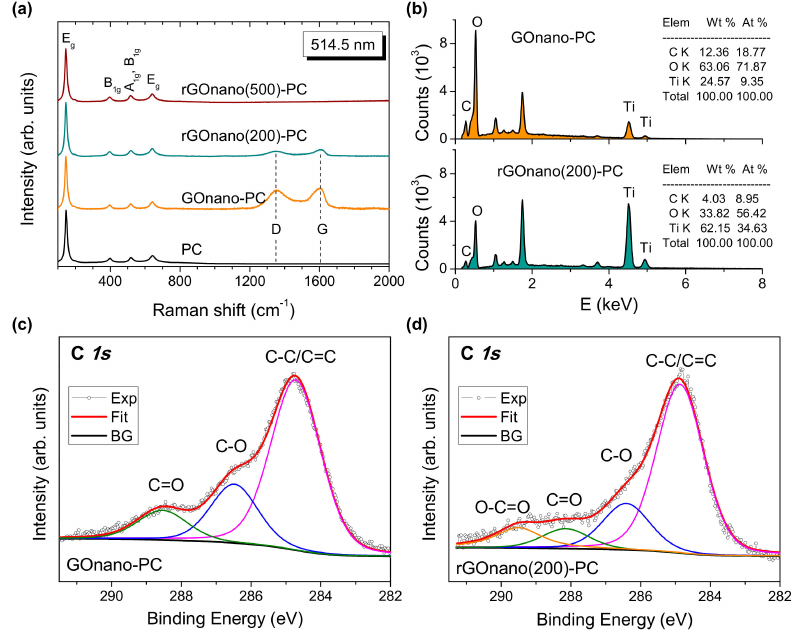
Figure 3. ( a ) Raman spectra of the pristine and modified inverse opals. ( b ) Energy-dispersive X-ray spectroscopy (EDX) spectra and C, O, Ti elemental analysis for GOnano-PC and reduced rGOnano(200)-PC. C 1s X-ray photoelectron spectroscopy (XPS) spectra for the ( c ) GOnano-PC and ( d ) rGOnano(200)-PC